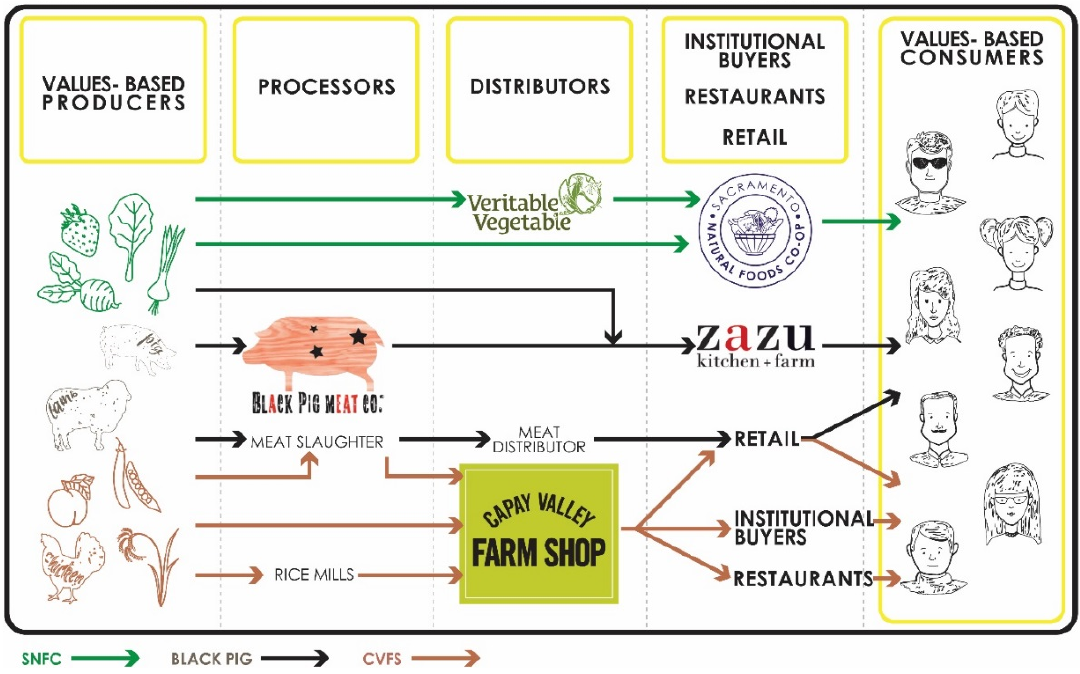
Figure 1. Partners in a values-based supply chain.